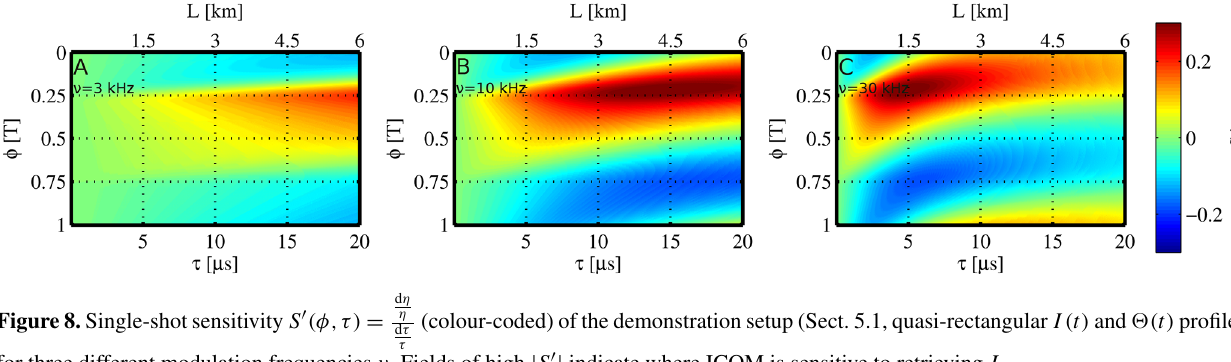
d η η (colour-coded) of the demonstration setup (Sect. 5.1, quasi-rectangular I(t) and (cid:50)(t) profile), d τ τ